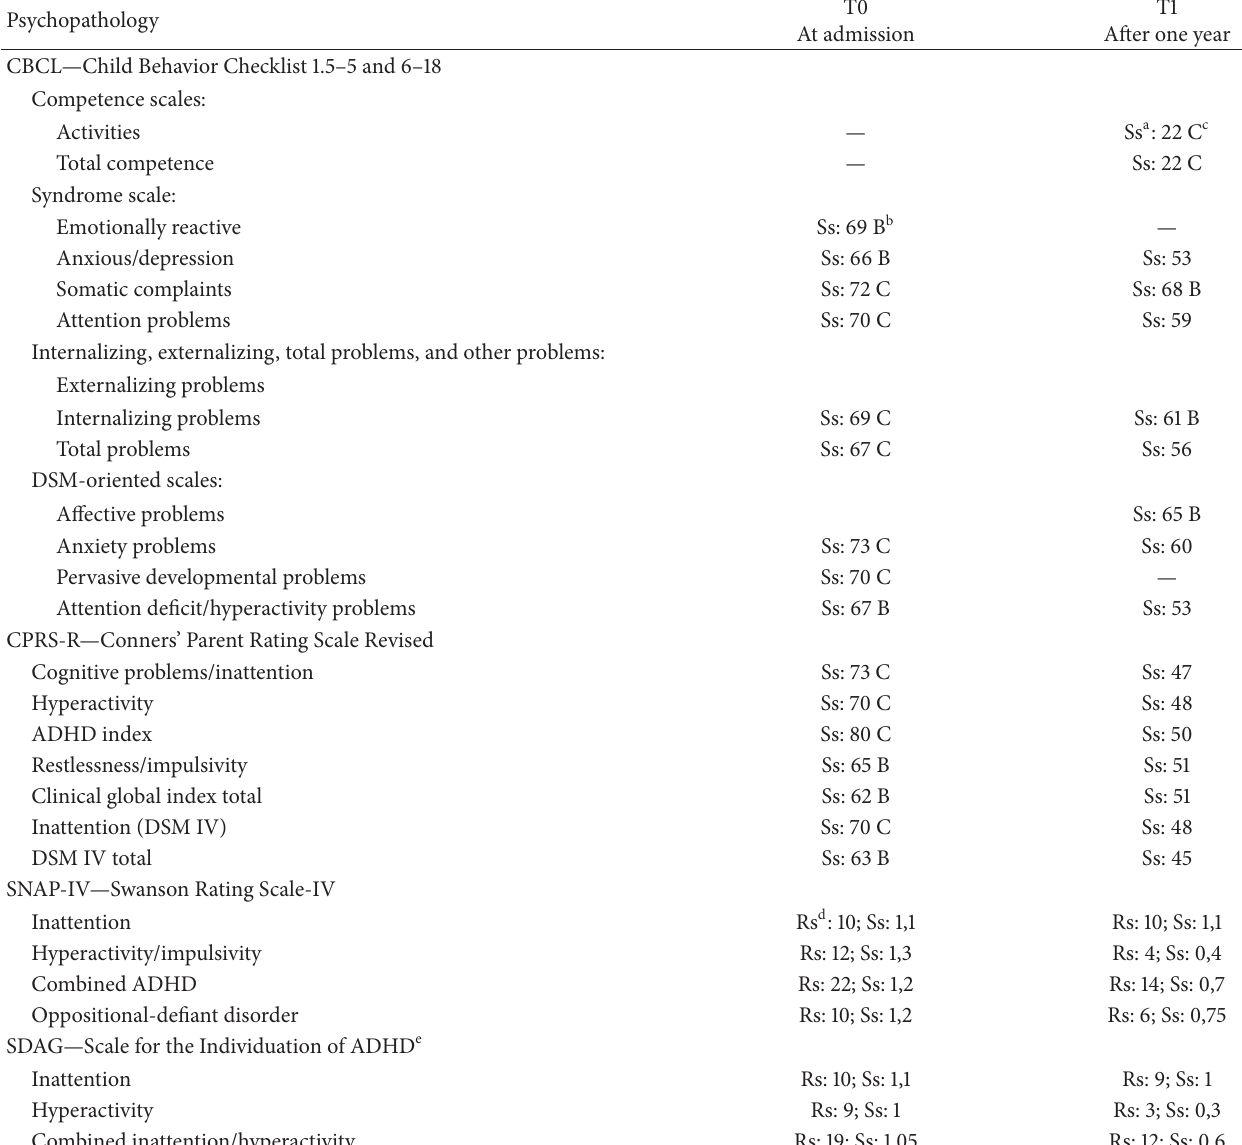
Table 2: Longitudinal psychopathology